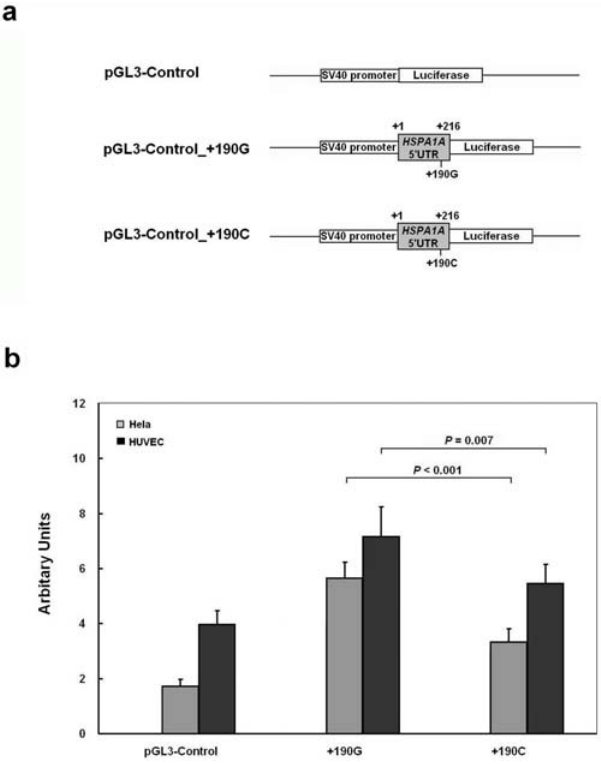
Figure 2. Effect of + 190G/C polymorphism on the expression of luciferase. (a), Schematic representation of reporter constructs. (b), These constructs and empty pGL3-Control plasmid were transfected into Hela and HUVEC cells. All constructs were cotransfected with pRL- SV40 to standardize the transfection efficiency. RLA was determined 24 hours later in normal culture condition. The RLA values are presented as means, and the T bars represent standard deviations (SD). Mean 6 SD from triplicates.